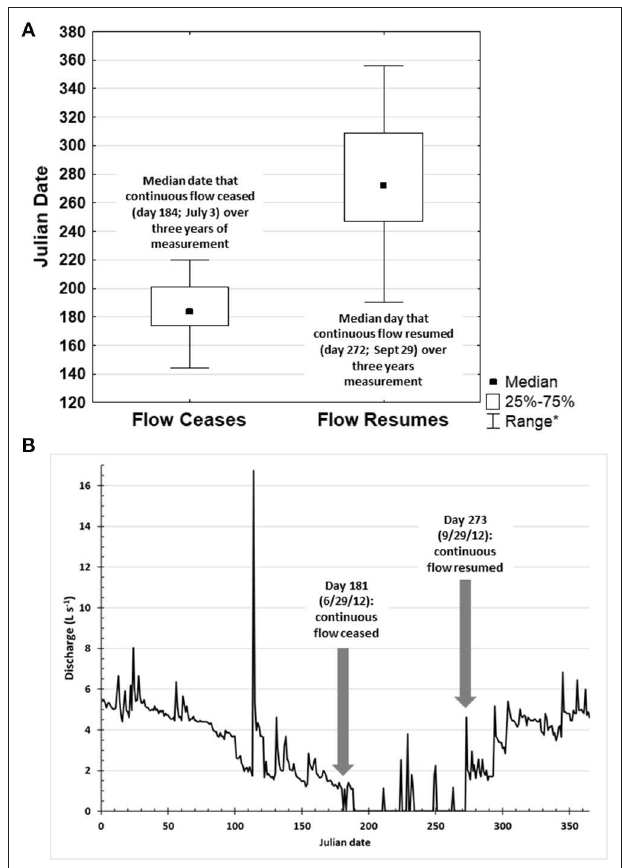
FIGURE 2 | Hydroperiods of intermittent streams. (A) Julian dates when continuous flow ceased and resumed in 12 intermittent streams in the Northeast USA over 3 years. (B) Example of the discharge (L s − 1 ) over Julian dates in 2012 derived from stage data at Site 4 and the site-specific stage-discharge relationship. Arrows indicate when continuous flow ceases (Julian date 181) and resumes (Julian date 273). *The range excludes outliers (point which falls more than 1.5 times the interquartile range above the third quartile or below the first quartile) and extremes (point which falls more than 3.0 times the interquartile range above the third quartile or below the first quartile).